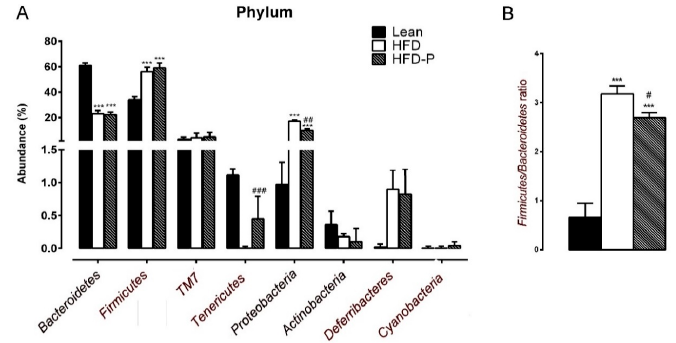
Figure 5. 16S rDNA sequencing of bacterial DNA in the feces of the lean, HFD, and HFD-P mice, in order to discriminate the intestinal microbial profile. ( A ) Graphic representation of the relative abundance (%) of the gut microbiota phyla composition of the three groups of animals. ( B ) Ratio of Firmicutes to Bacteroidetes in the lean, HFD, and HFD-P. Data are expressed as mean ± SEM; ( n = 8/group). (*** p < 0.001); hash denotes significant difference when compared to the HFD group (# p < 0.05; ## p < 0.01; ### p < 0.001).